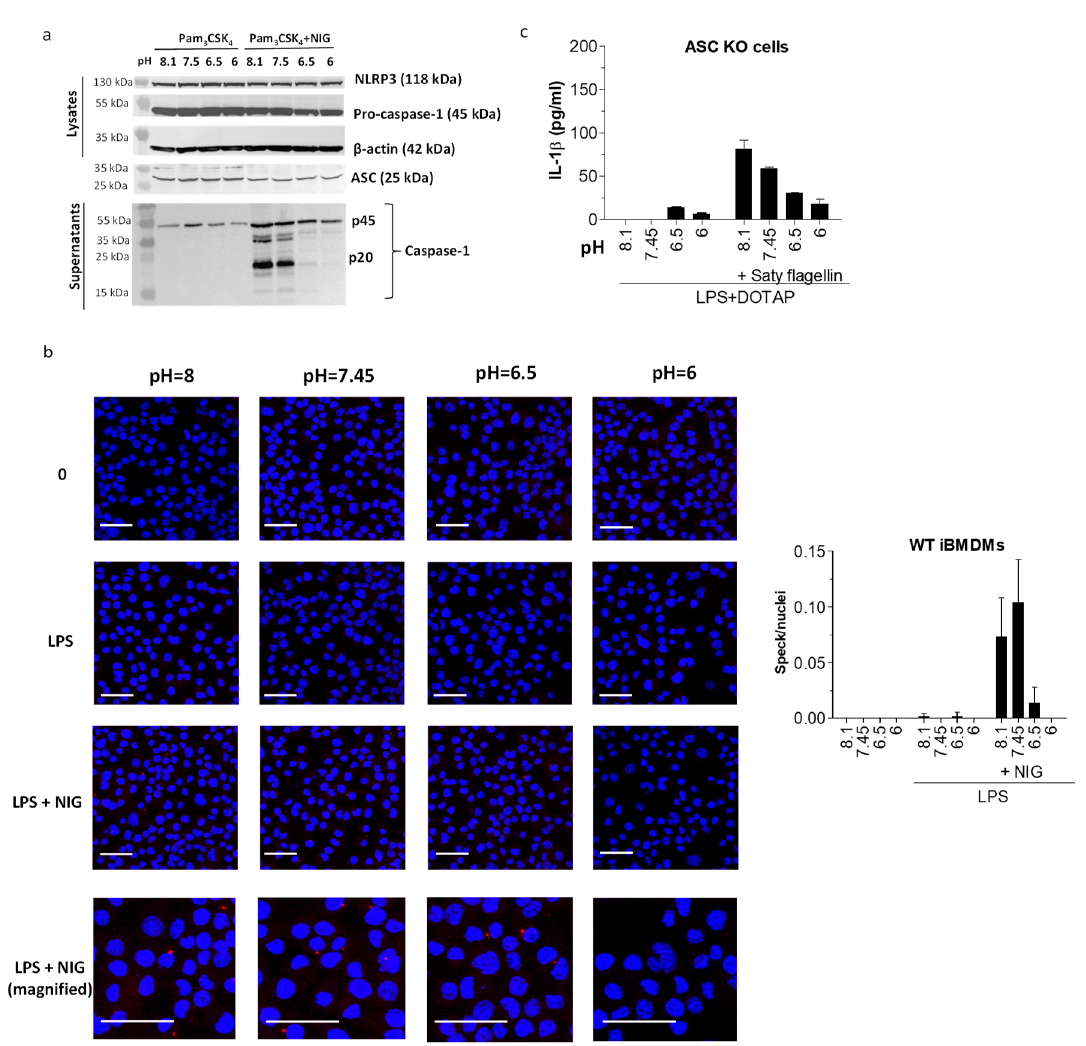
Figure 5. pH sensitivity was conferred upstream of apoptosis-associated speck-like protein containing a caspase activation and recruitment domain (ASC) oligomerization. ( a ) Detection of caspase-1 in supernatants and pro-caspase-1, NLRP3, and ASC in lysates with Western blot after iBMDMs were treated overnight with 200 µ g / mL Pam3CSK4 and 1 h with 10 µ M nigericin or bu ff ers alone. ( b ) Detection of ASC specks (red aggregates) in immunofluorescently labelled WT iBMDM with confocal microscopy after cells were primed with 100 ng / mL LPS, followed by caspase-1 inhibition by 30 min